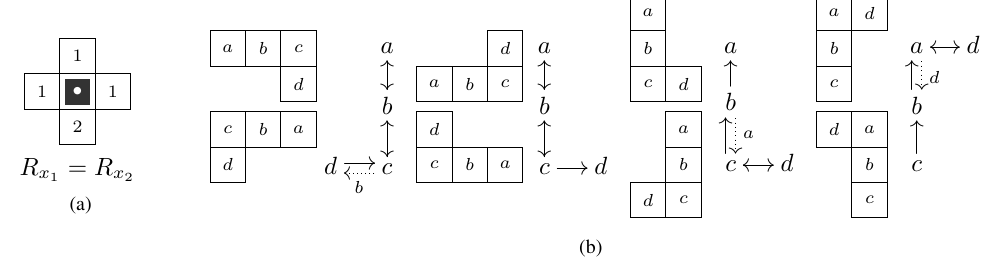
Figure 17: (a) A (2 , 6) priority strategy for the breaker for P 4 , 2 (b) Dependency digraph of the cells in the orientations of P 4 , 2 with secondary arrows